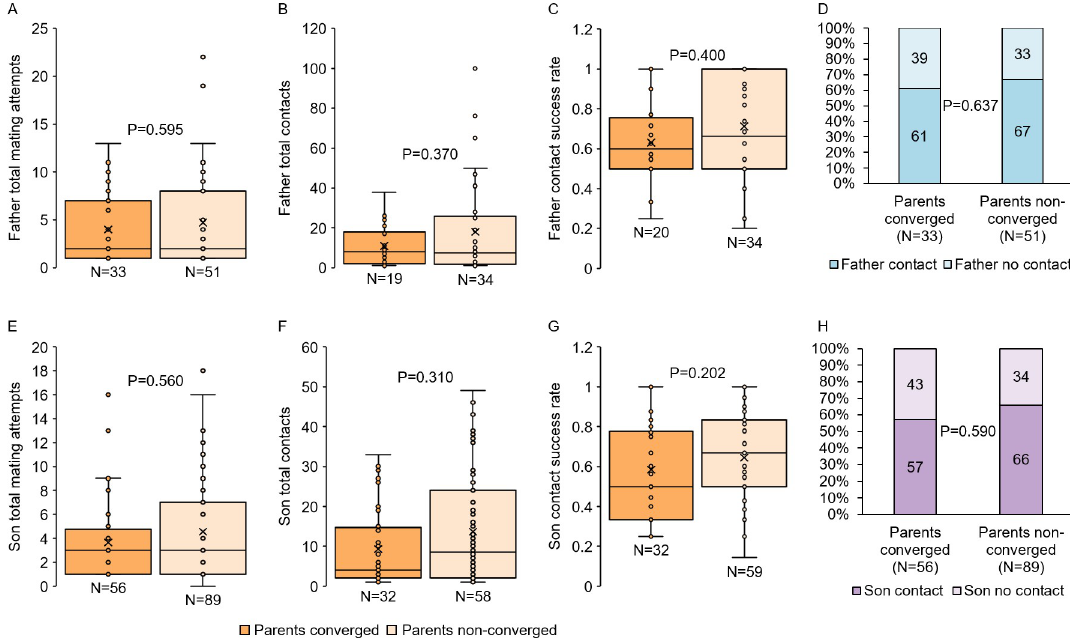
Fig 4. Harmonic convergence signals neither parent nor offspring flight performance. Neither father (A–D) nor son (E–H) flight performance metrics differed by parental convergence status (P � 0.202 for all comparisons). Graphs display sample sizes (N) and LMM or GZLMM P-values for each comparison.